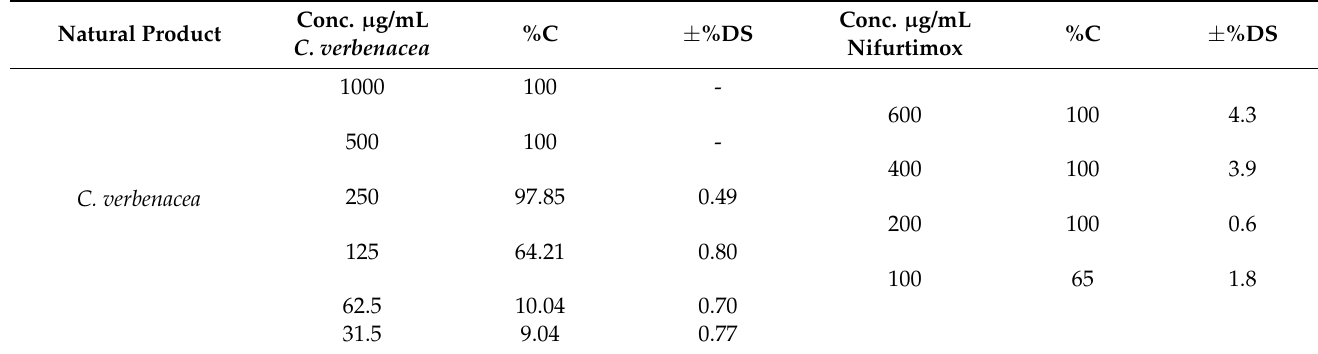
Natural Product